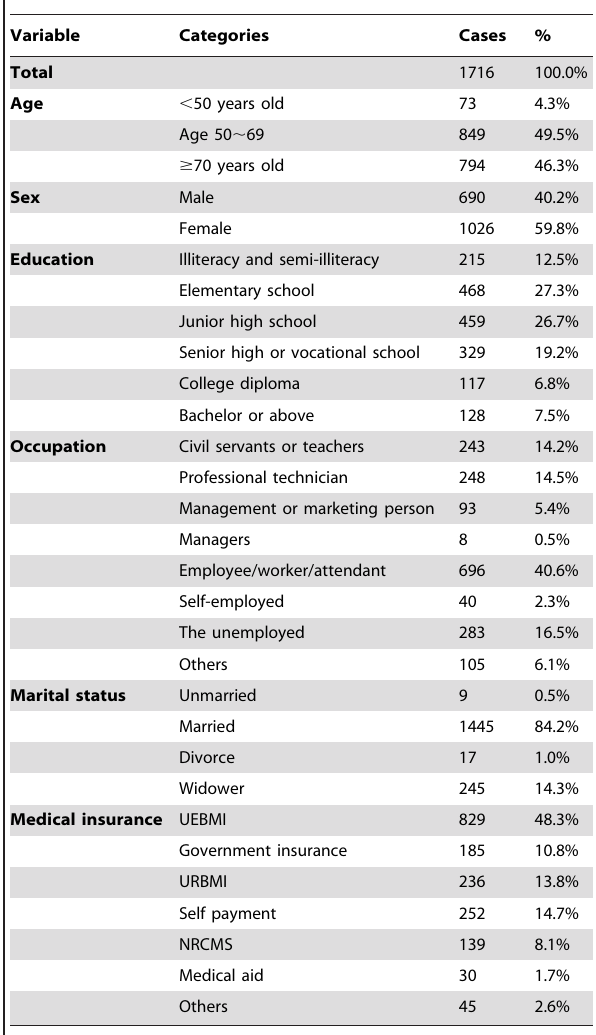
Table 1. Demographic and social characteristics of hypertensive